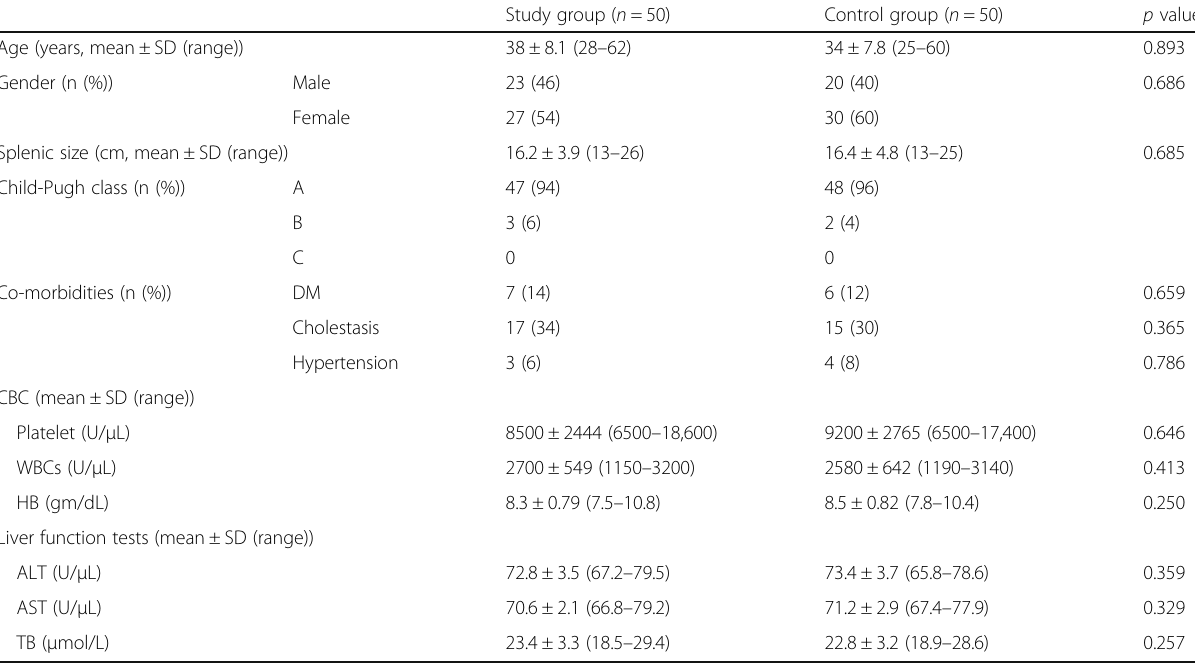
Table 1 Demographics and co-morbidities of patient groups